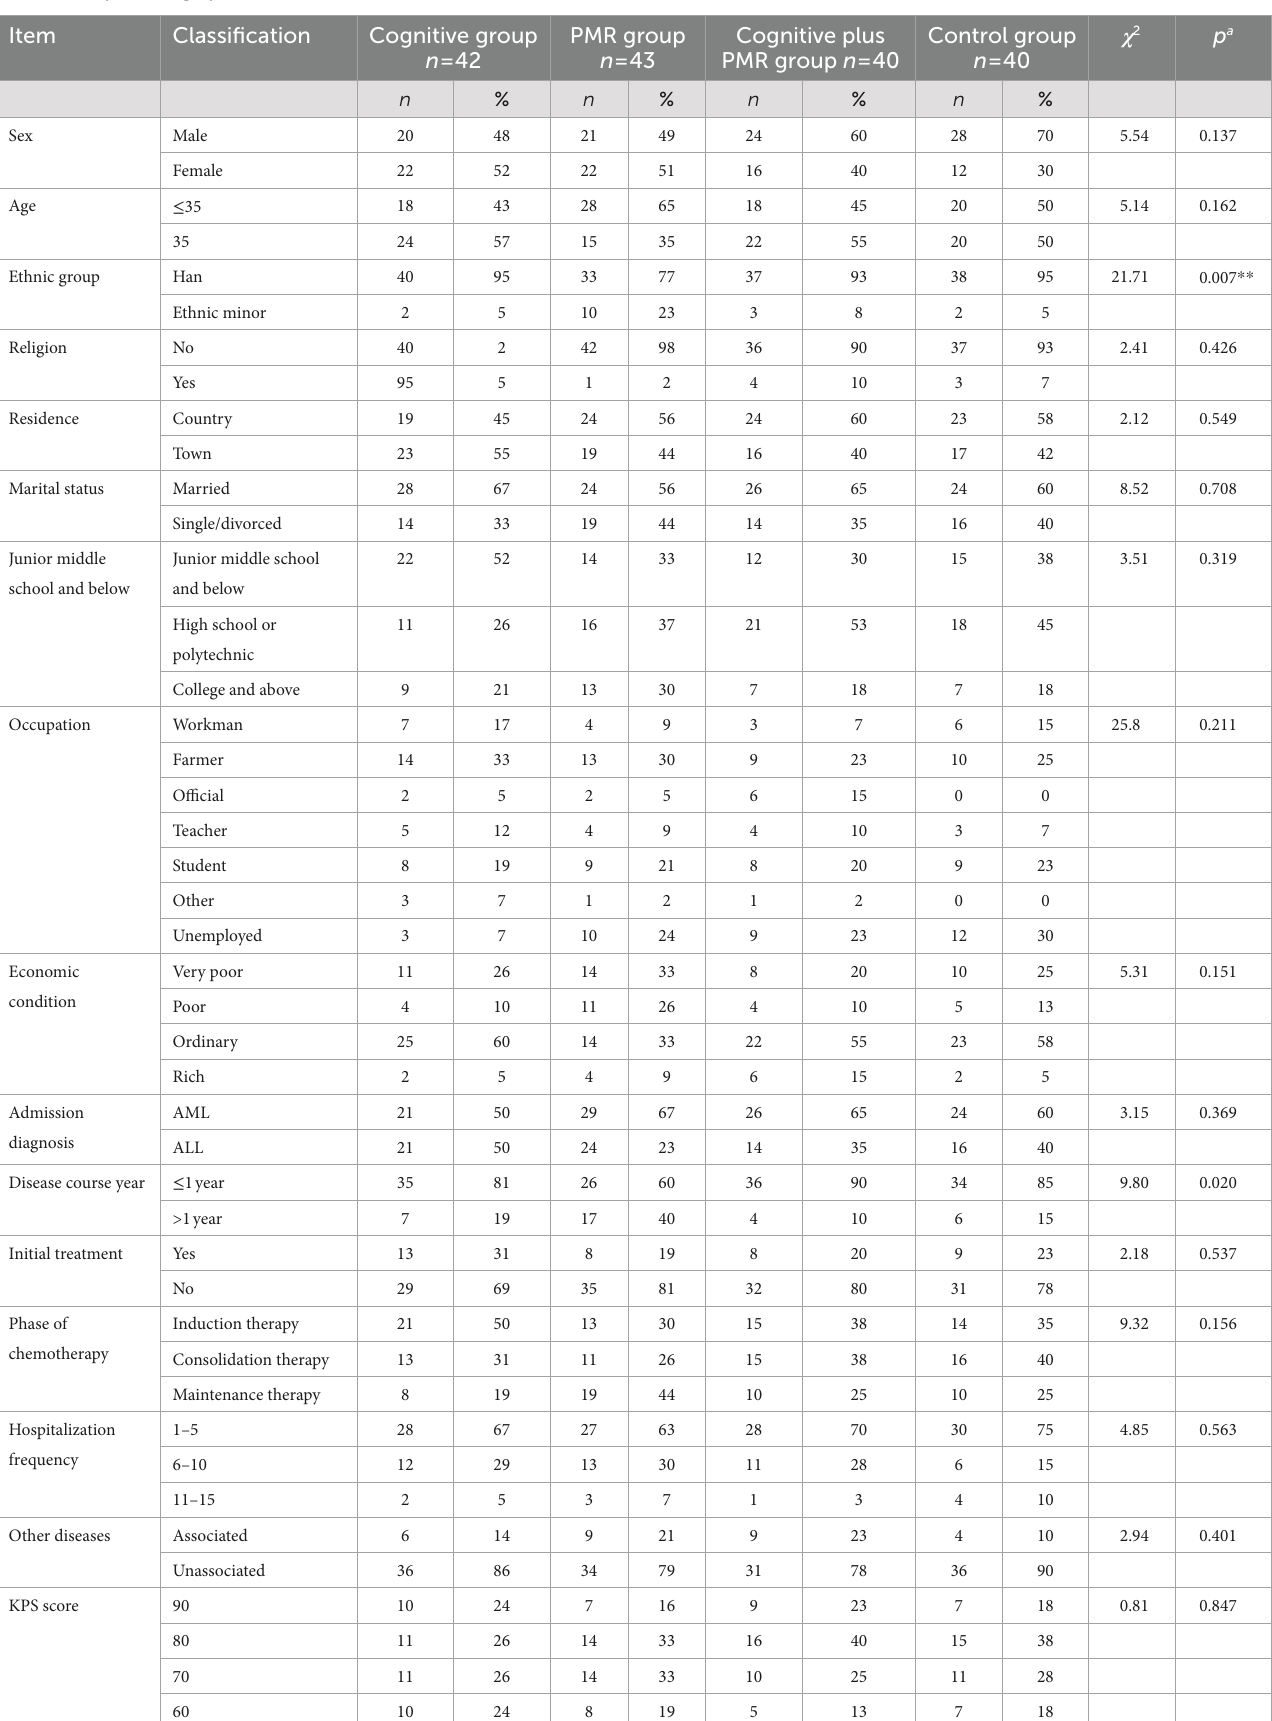
TABLE 1 Sample demographics and clinical